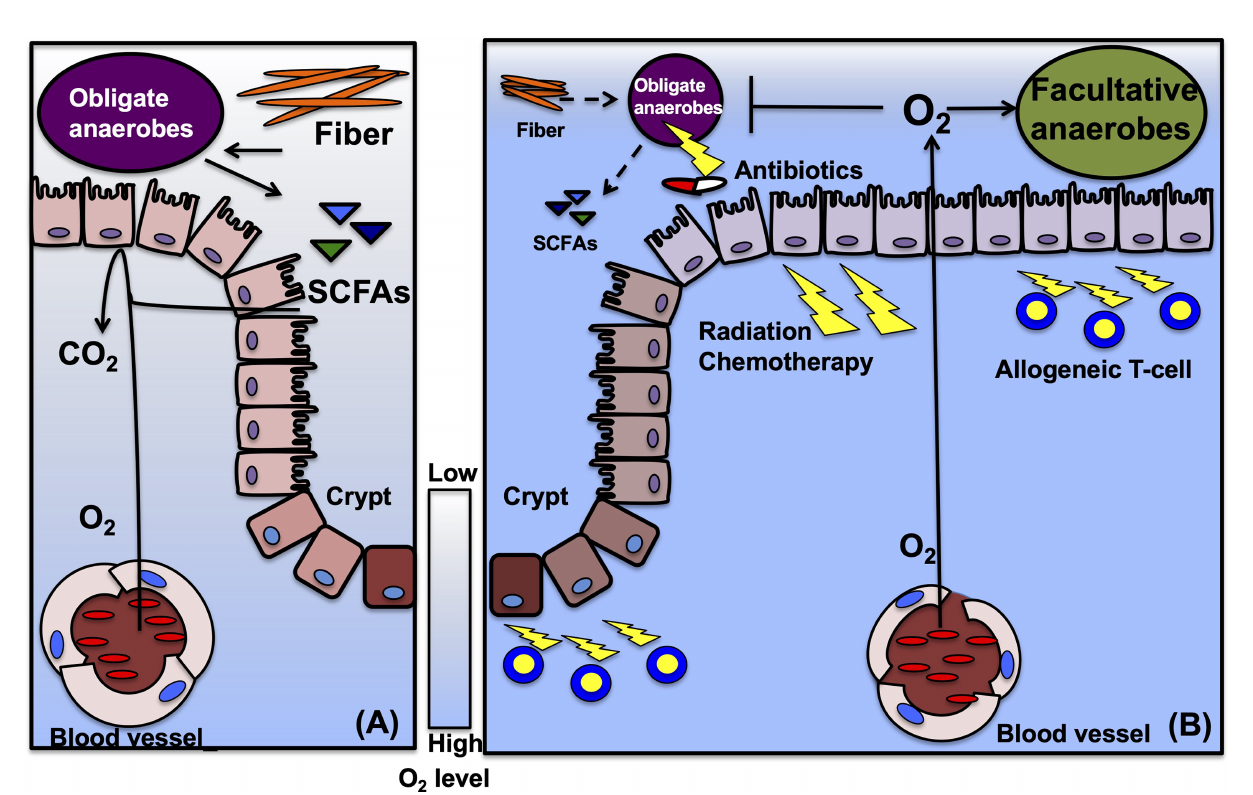
FIGURE 1 | Suggestive mechanisms of epithelial metabolism and gut microbiota in HSCT. (A) Before HSCT, gut microbiota, especially obligate anaerobic bacteria, ferment fi ber from diet into metabolites, such as SCFAs. Intestinal epithelial cells (IECs) metabolize short chain fatty acids (SCFAs) and consume oxygen to produce energy. High oxygen consumption limits the oxygen diffusion into the lumen and maintains hypoxia in the lumen. Hypoxic condition enables obligate anaerobes to keep growth. The scale bar indicates oxygen (O 2 ) levels, usually between 3% to 10% in normal intestines. (B) During HSCT, conditioning treatments including irradiation and high-dose chemotherapy damages IECs, and injured IEC decreases oxygen consumption. Decreased dietary fi ber and antibiotics treatments during HSCT disrupt microbiota composition, especially reduce obligate anaerobes, and deplete the fermentative products. Reduced SCFAs limit oxygen consumption to produce energy in IECs and permit oxygen diffusion into the gut lumen. Elevated oxygen concentration drives an expansion of facultative anaerobic bacteria and might lead to a contraction of obligate anaerobes. In GVHD, allogeneic T-cells promote IEC injuries and require antibiotics treatments, that could enhance and maintain dysbiosis in the